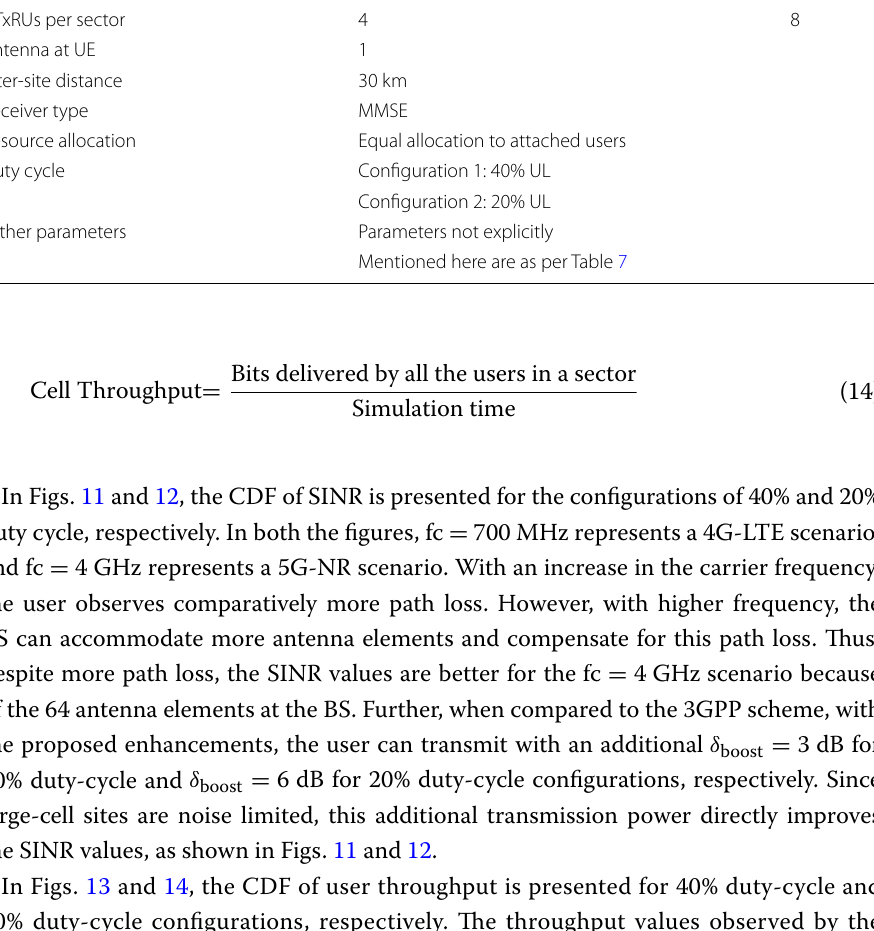
Table 8 Simulation parameters for system-level evaluation Parameter Scenario 1 Scenario 2 Carrier frequency (fc) 700 MHz 4 GHz N P Antenna at BS [ M × ×